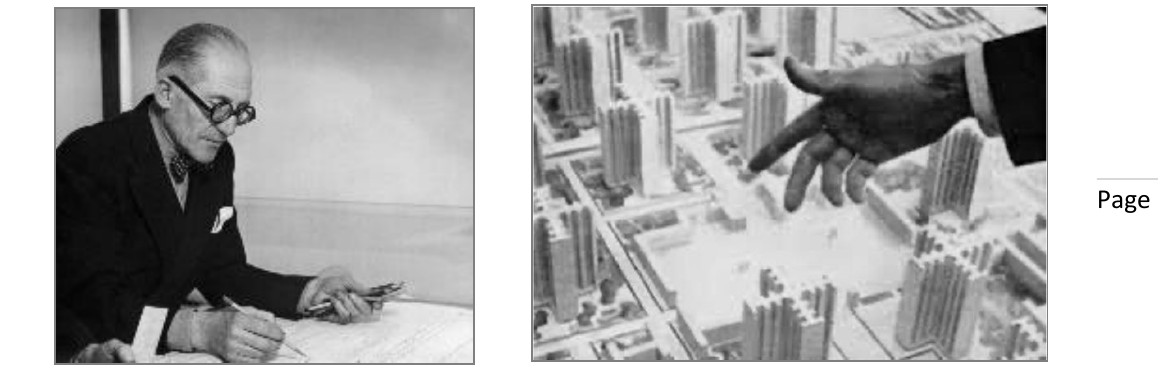
Figure 4 Le Corbusier (URL-2) Figure 5 Le Corbusier’s Voisin Plan Model, 1924